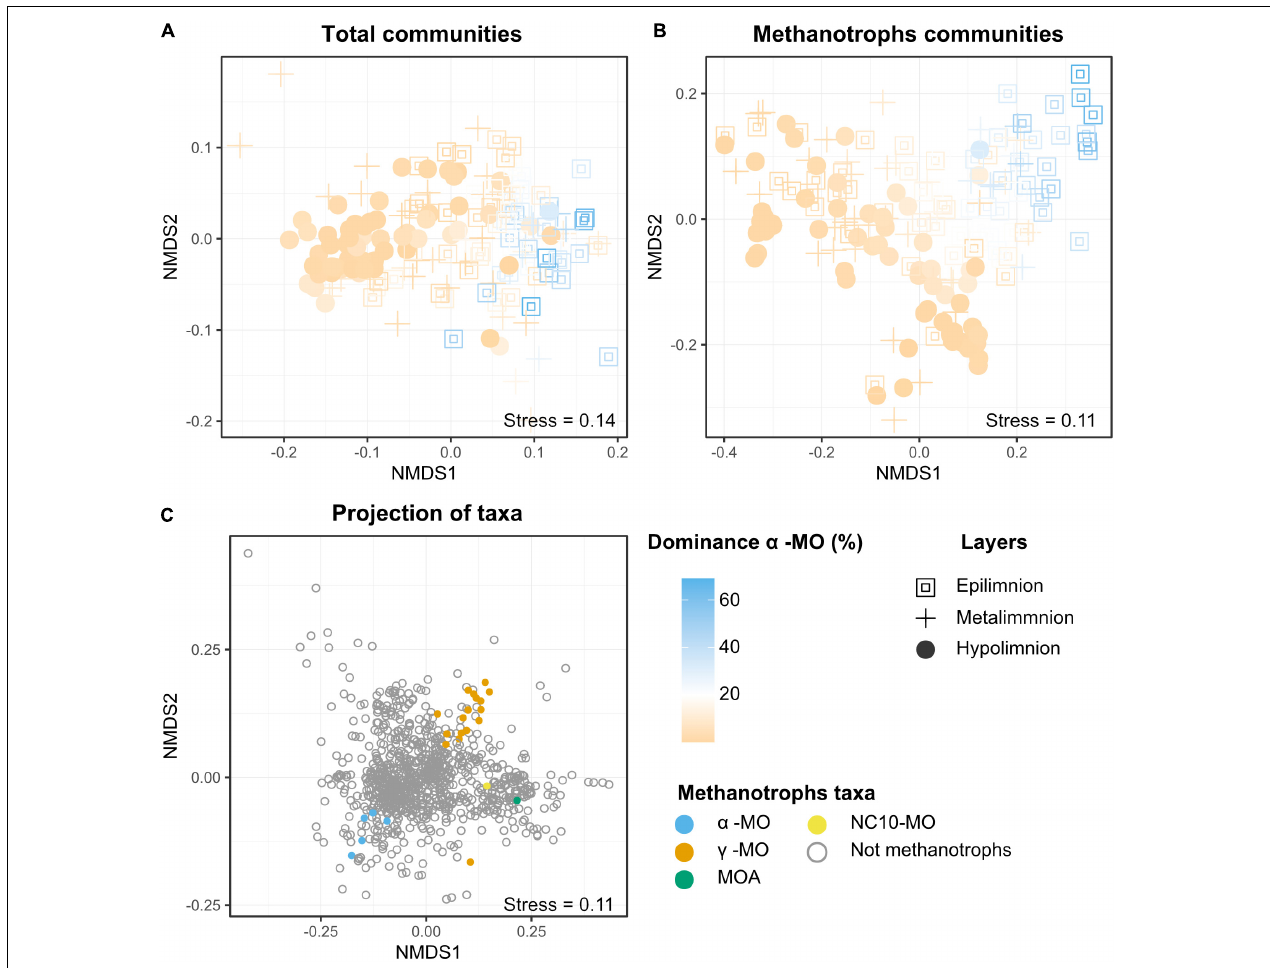
FIGURE 5 | NMDS plots visualizing the composition of the (A) total and (B) methanotrophic (MO) communities in the samples as well as (C) distribution of different taxa. In (A,B) , colors represent the dominance of alphaproteobacterial methane oxidizers (i.e., the proportion of reads attributed to α -MO among all the reads attributed to MO) in each of the samples. The non-linear color scale visualizes that, except for one samples, all the samples with more than 20% of the MO communities belonging to the Alphaproteobacteria are grouped and belong to the epilimnion or the metalimnion (blue). Samples with MO communities dominated by Gammaproteobacteria (orange) are spread across the plot, including the area where Alphaproteobacteria dominated. They also include samples from all the three layers. The layers are a proxy for oxygen levels, epilimnion being fully oxic, metalimnion poor in oxygen ( > 0.2 mg/l), and hypolimnion anoxic. The taxa plot (C) shows the distance between the taxa based on their relative abundances in the samples. For readability purpose, only the 900 most abundant taxa are plotted. The MO taxa represented are alphaproteobacterial methanotrophs ( α -MO), gammaproteobacterial methane oxidizers ( ), methanotrophic Archaea (MOA), and bacterial phylum N10